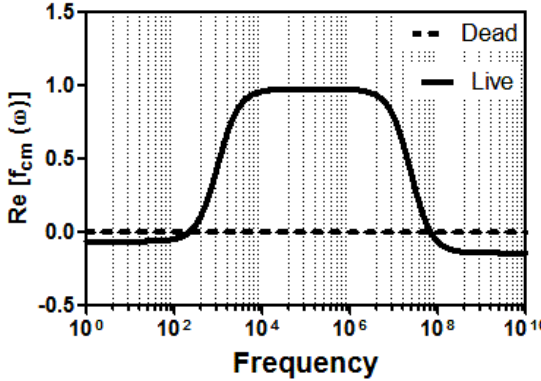
Figure 1. Characterization of the live and dead U937 monocytes. The Re [ f cm ( w )] vs. frequency (Hz) data is obtained using the dielectric properties of the live (continuous line) and dead (dashed line)